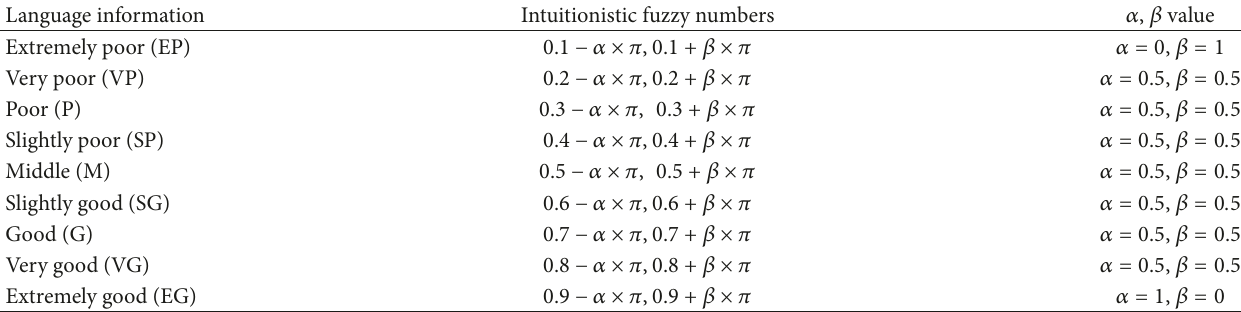
Table 1: The intuitionistic fuzzy numbers corresponding to the language